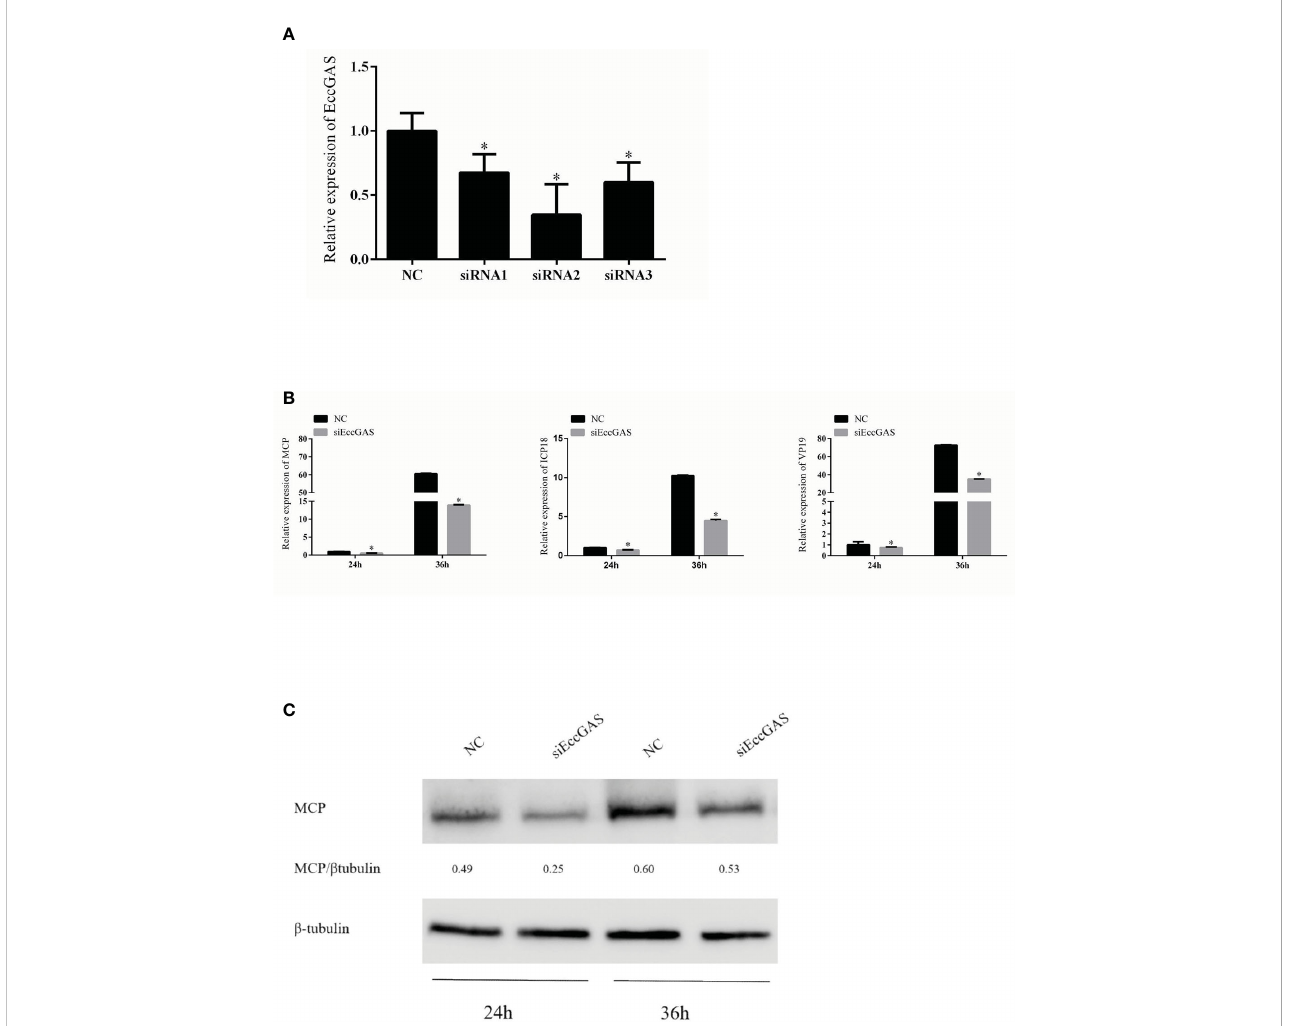
FIGURE 5 Effect of EccGAS silencing on viral replication. (A) Three siRNA sequences were designed based on the sequence of EccGAS and assayed for interference effects. (B) EccGAS knockout and control cells were infected with SGIV and collected at 24 h and 36 h to measure the relative expression levels of the viral genes. Relative expression levels of the viral genes were measured by qRT-PCR (n = 3, mean ± SD). * P < 0.05. (C) Silencing of EccGAS in GS cells infected with SGIV and protein samples collected for 24 h and 36 h. Expression of MCP protein was detected by western blotting. b -tubulin was used as an internal control. Quantity-one software was used to calculate band intensities and assess the MCP/ b -tubulin